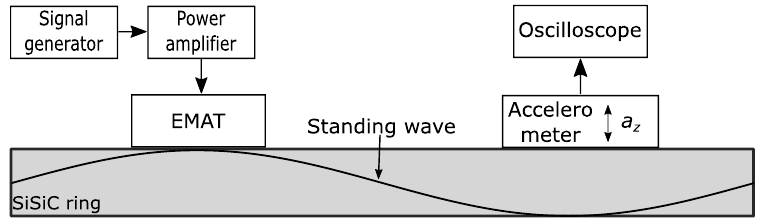
Figure 10. Block diagram of the measurement setup. The signal generator output provided a sinusoidal signal. The signal was amplified and fed toward the EMAT. The EMAT continuously drove mechanical waves into the ring, generating a mechanical oscillation inside the ring. An accelerometer measured the acceleration in the